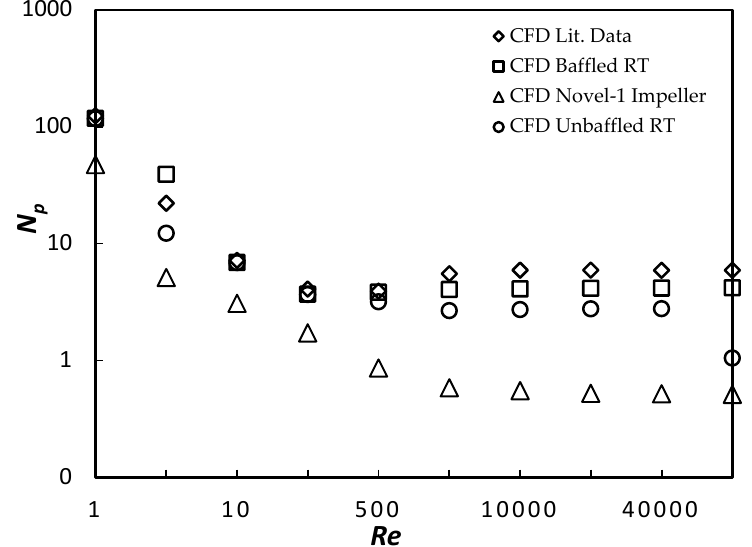
Figure 4. A comparison of power number N p of CFD predictions with literature data [10].